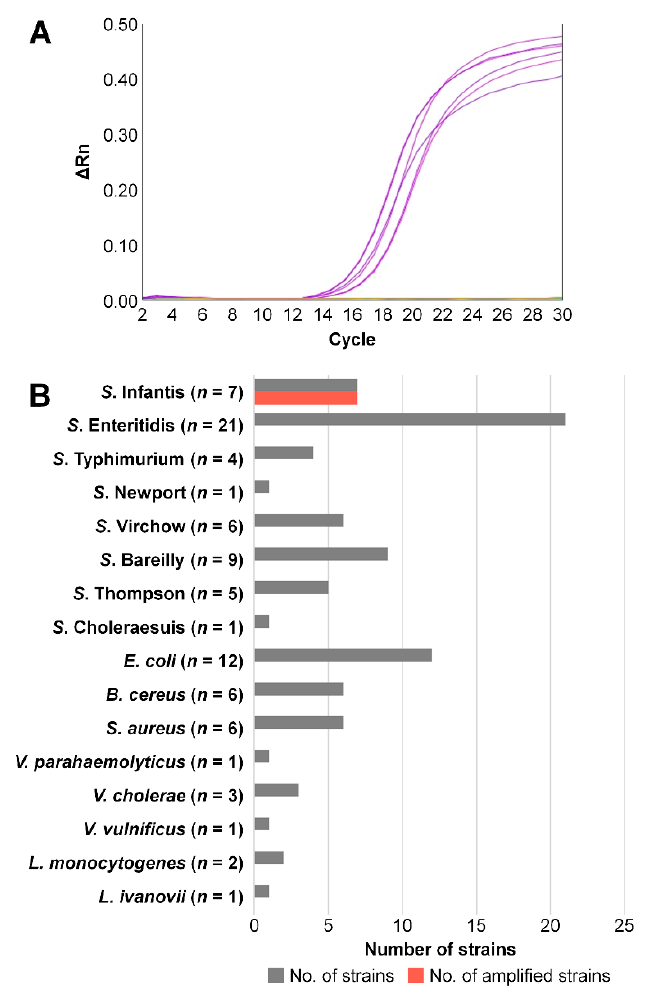
Figure 6. Validation of the specificity of the designed primer set using isolates of diverse origins. ( A ) Real-time PCR results on 54 Salmonella strains. Only the seven tested S. Infantis strains yielded a PCR product. ( B ) Specificity results on 54 Salmonella strains and 32 non- Salmonella strains. Gray bars denote the numbers of tested strains, and red bars represent the numbers of strains that yielded amplification with the proposed diagnostic primer set.